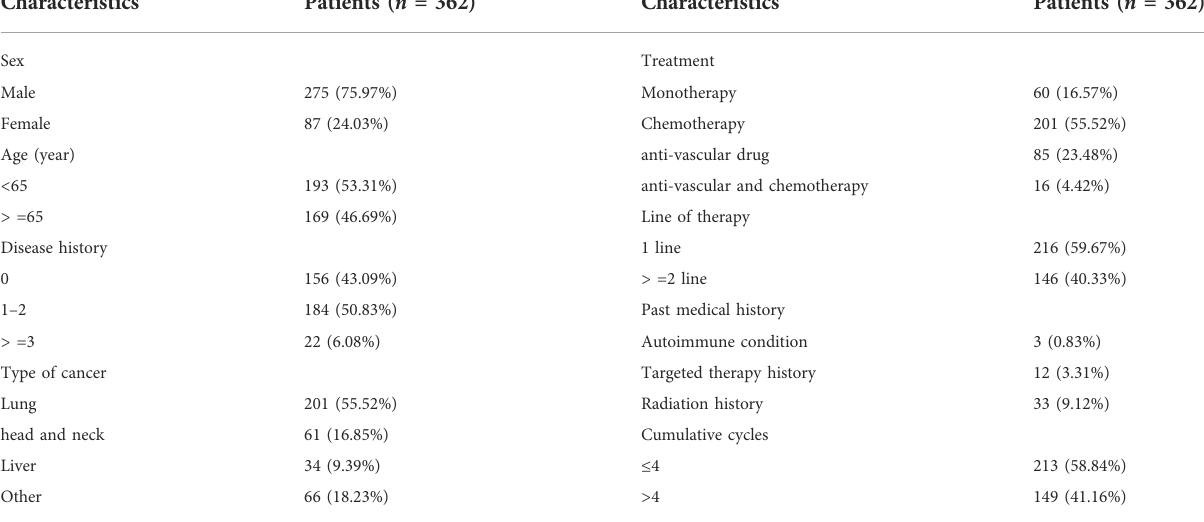
TABLE 1 Clinical characteristics of patients with